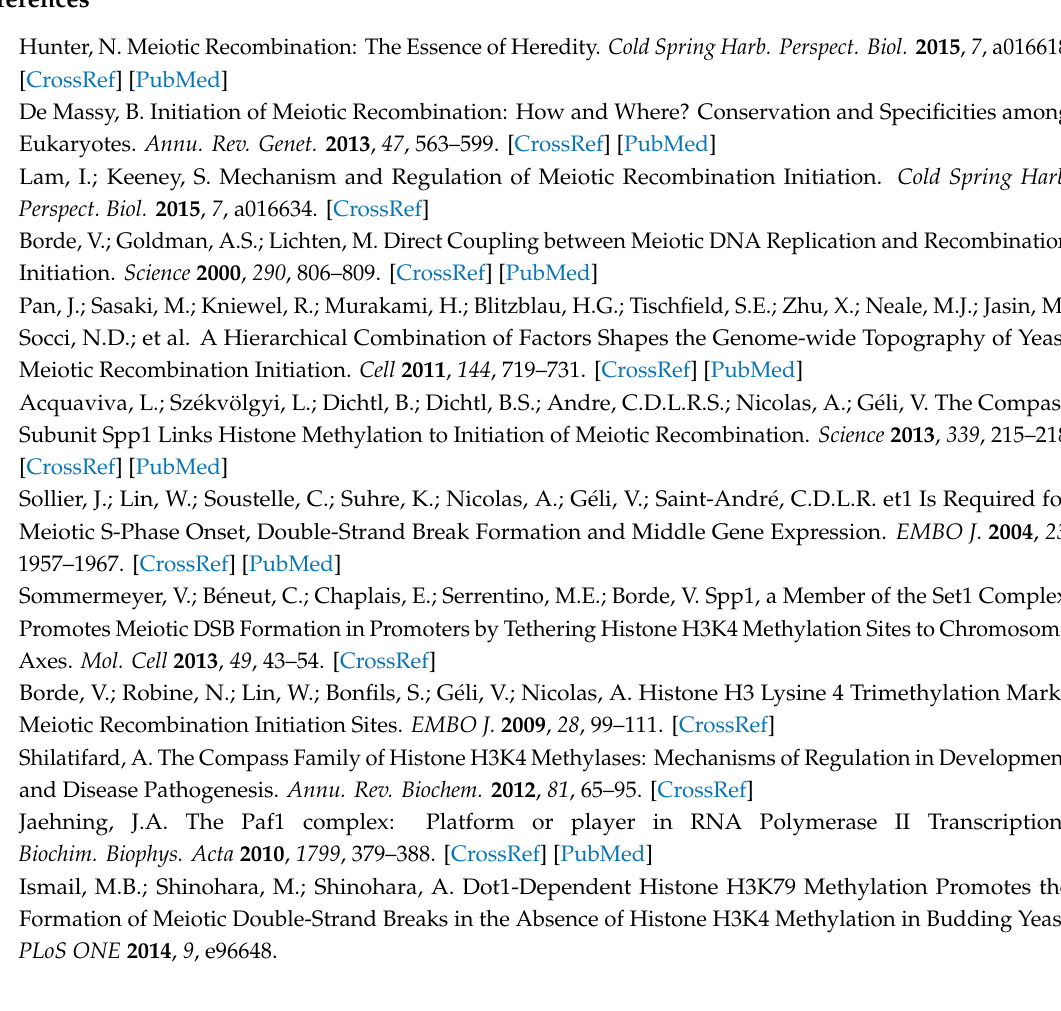
Figure S1: Western blotting analysis of histone modifications in various strains during meiosis, Figure S2: Rad51-staining in SPO11-Flag strains, Figure S3: Numbers of Rec114-myc foci in various strains, Figure S4: DSB formation at the HIS4-LEU2 loci in various dmc1 strains, Figure S5: Western blotting analysis of meiosis progression in various strains, Table S1: Strain list, Table S2: Statistics